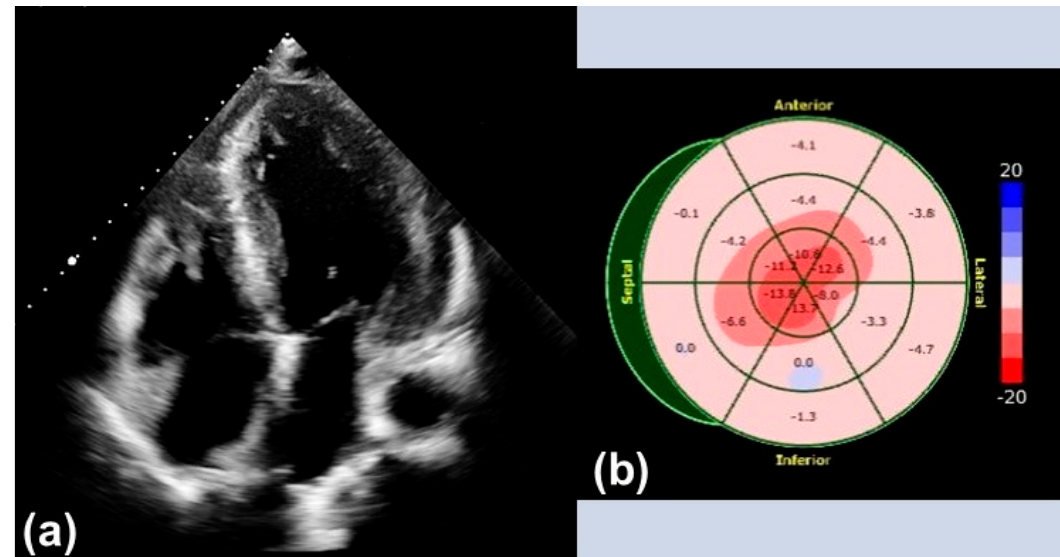
Figure 1. Typical findings in transthoracic echocardiography: ( a ) Apical four-chamber view with left ventricular hypertrophy. ( b ) Echocardiographic strain imaging with ‘cherry-on-top’ sign.